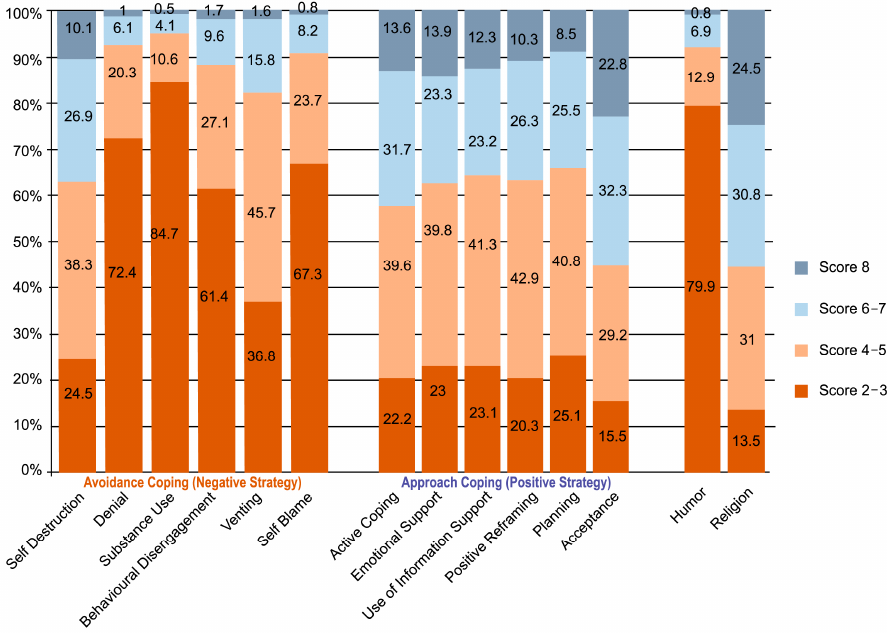
Figure 3. Population scoring distribution of coping styles.